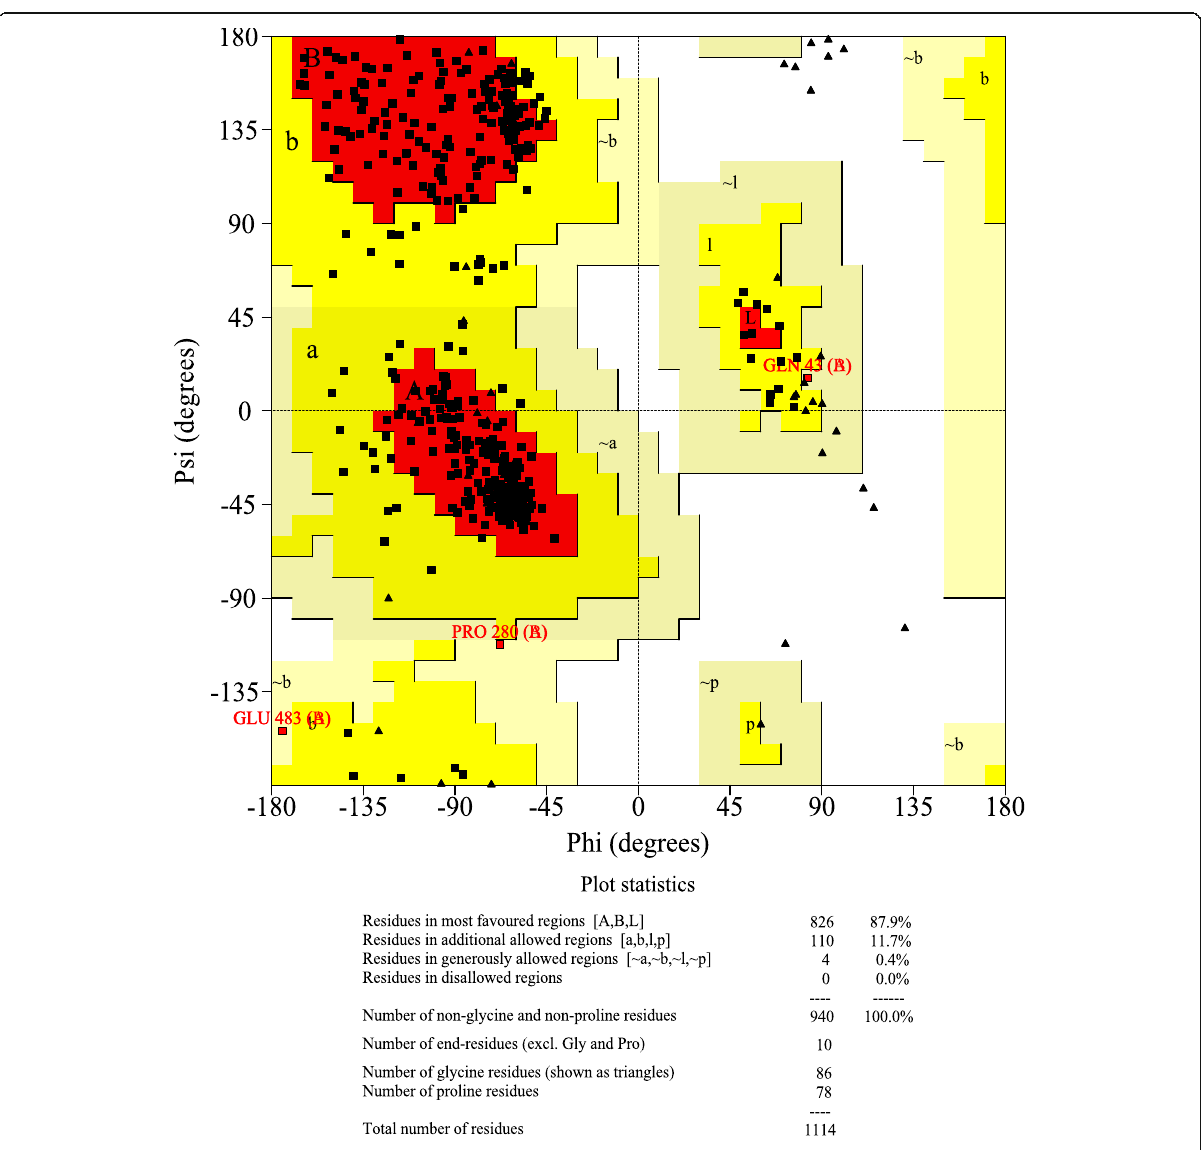
Fig. 1 2D-structures of flavanones (eriodictyol, hesperetin, and naringenin) and